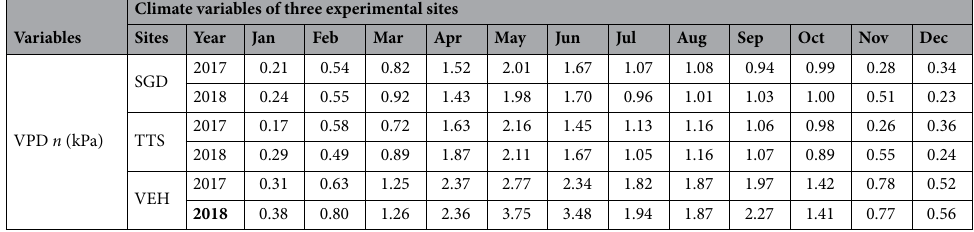
Table 1. Climate variables of experimental sites. RTD (relative temperature disparity), T p ( thermo temperature), T n ( nytco temperature), RHD (relative humidity disparity), RH p ( photo relative humidity),